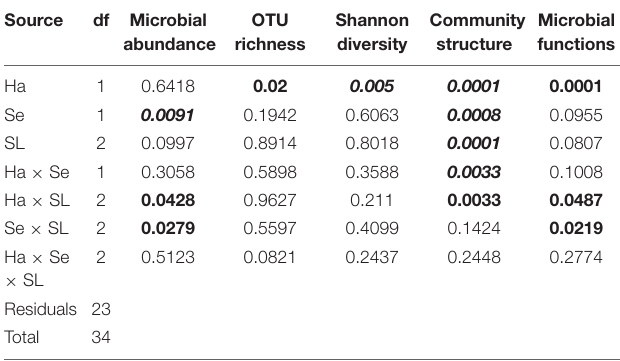
Chl a : phaeo in spring ( Supplementary Figure S3 ). The first two dbRDA axes explained 42.2% of the community variation ( Supplementary Figure S3